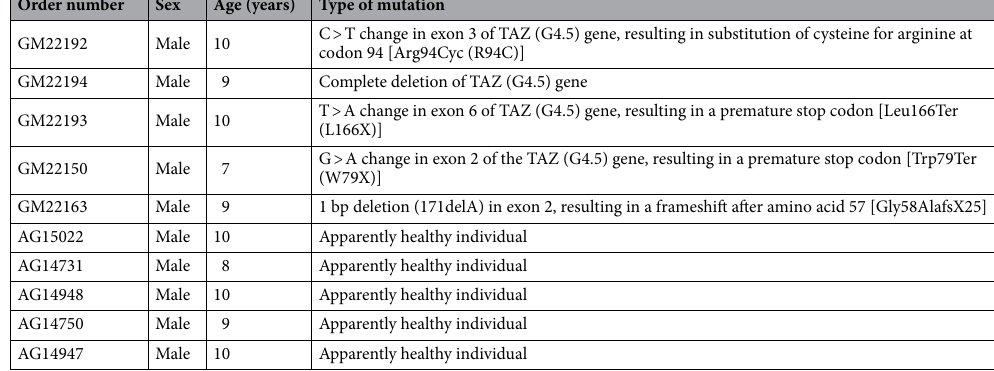
Table 1. Characteristics of individual BTHS patient and healthy donor lymphoblasts obtained from Coriell NIGMS—human genetic cell